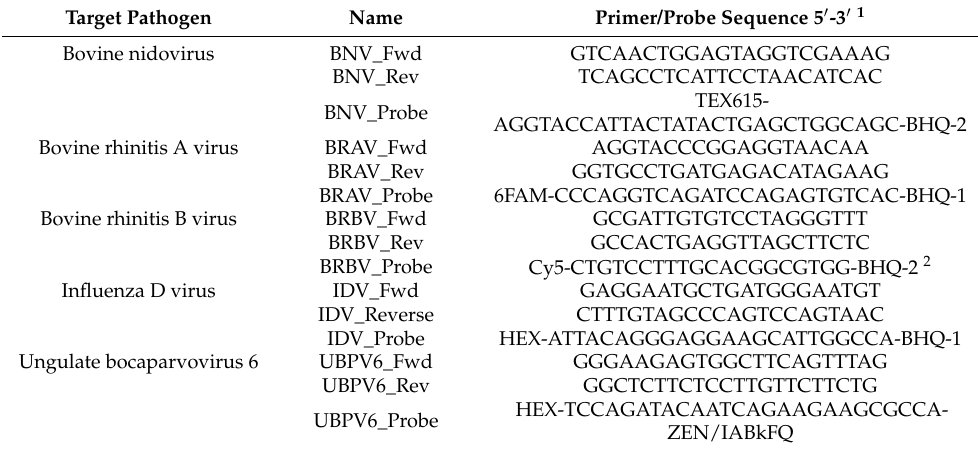
Table 1. Oligonucleotide pairs and dual-labelled hydrolysis probe sequences used for quantitative real-time PCR detection of the